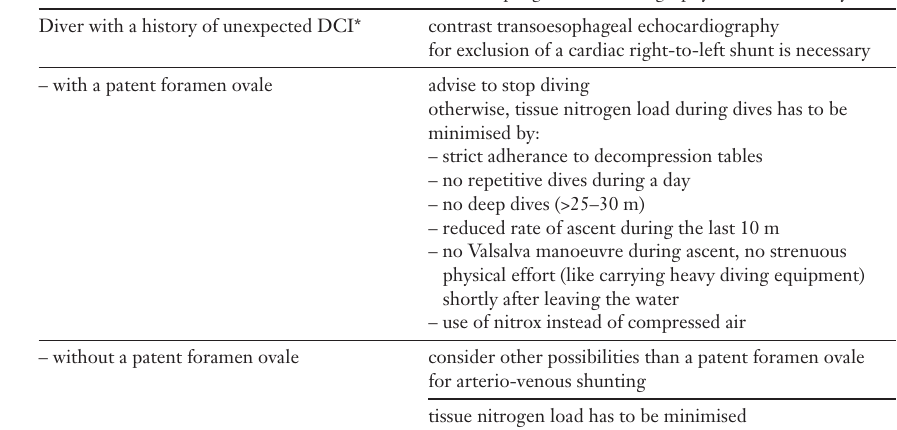
Recommendations for recreational divers with a patent foramen